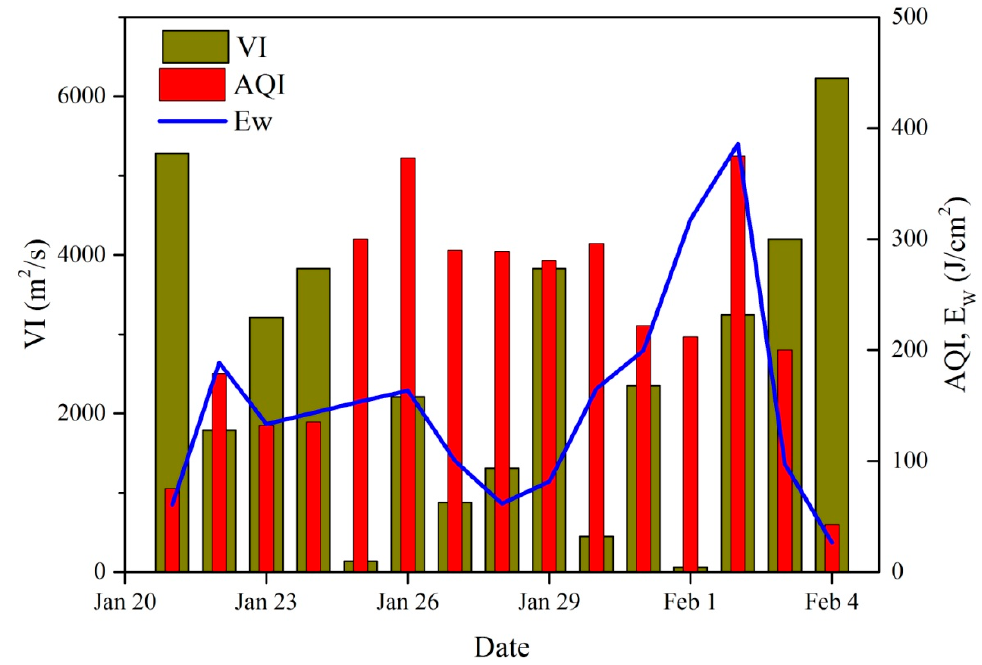
Figure 4. AQI at 0700 h LST, VI at 0700 h LST and E W at 550 m in the heavy pollution period (21